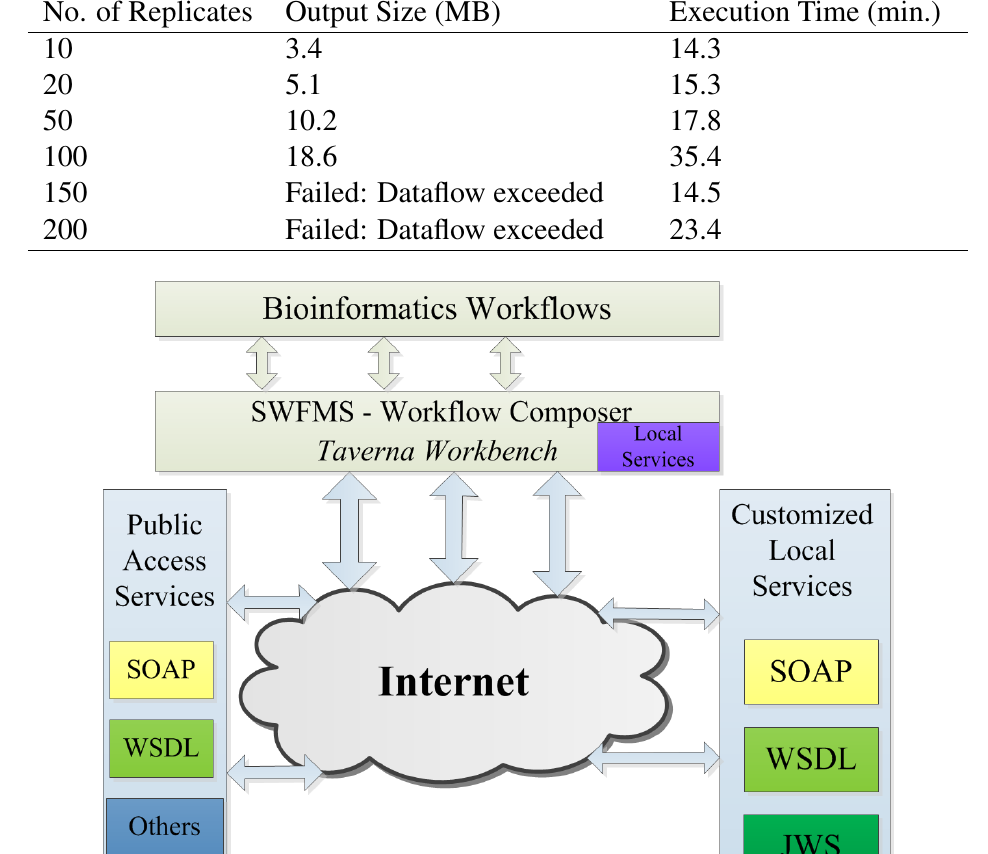
Table 2: The execution results of the preliminary tree inferring workflow for DNA of the 13-CDS dataset